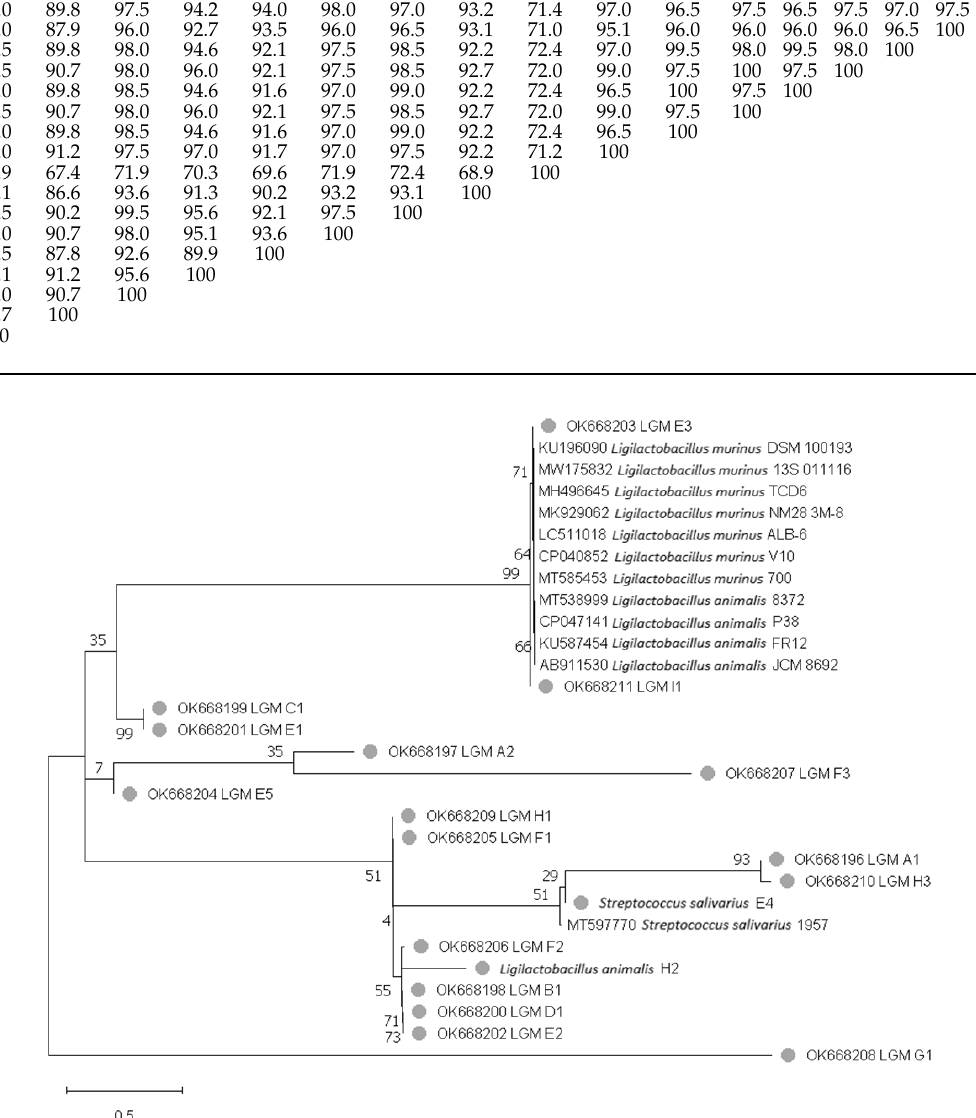
Figure 1. Phylogenetic tree built by the Maximum-Likelihood method, using the sequences of V2 variable region of the 18 LAB strains isolated from mice intestinal tract ( • ), compared with strains found in GenBank. The numbers expressed before each clade (shown in percentages) show the trust levels generated from 1000 bootstrap.